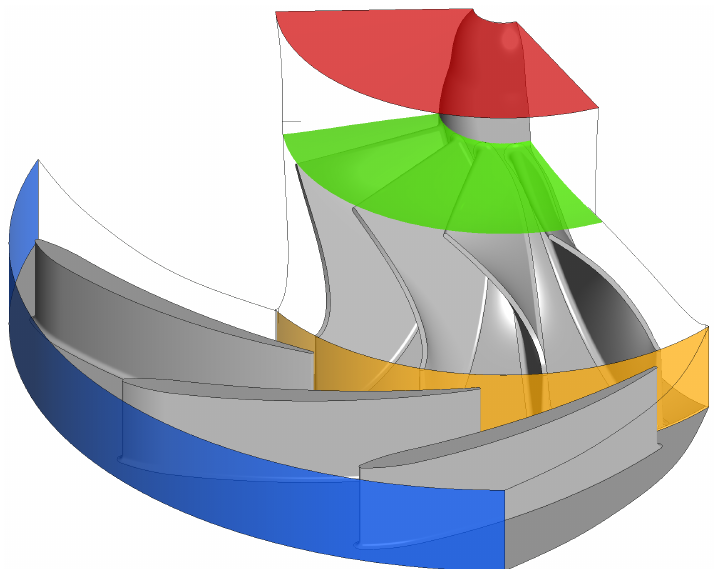
Figure 4. Stage matching domain with inlet (blue), frozen rotor interface (orange), outlet (red), and analysis plane (green). Adapted from [10]. Copyright 2021